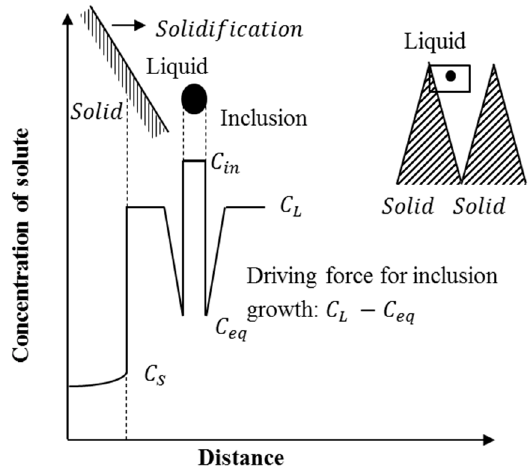
Figure 8. Schematic of inclusion precipitation and growth during solidification [113].